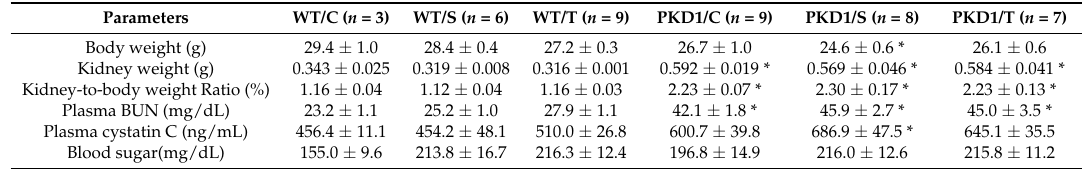
Table 1. Effect of trehalose on the metabolic and biochemical parameters of Pkd1 miRNA transgenic mice.